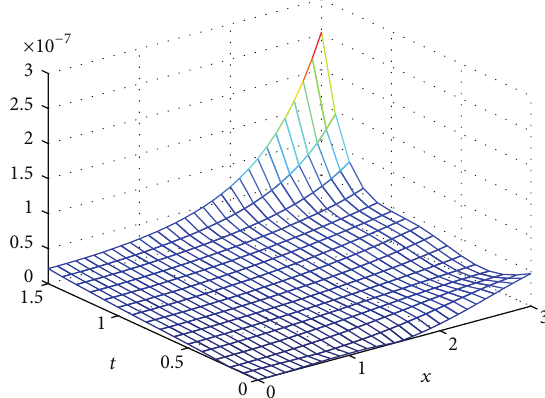
Figure 2: Plot of the absolute error functions |𝑢(𝑥,𝑡) − 𝑢(𝑥,𝑡)| for the exact solution 𝑢(𝑥,𝑡) = 𝑒 −0.2𝑥+0.1𝑡+0.3 .